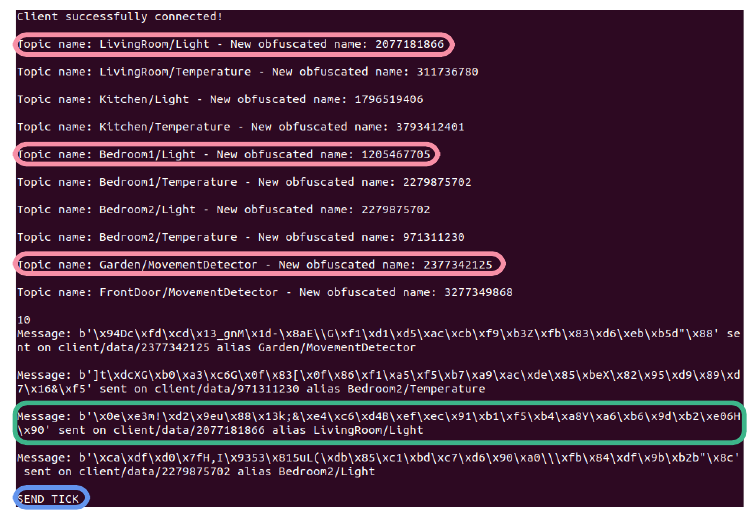
Figure 7. Publisher’s View